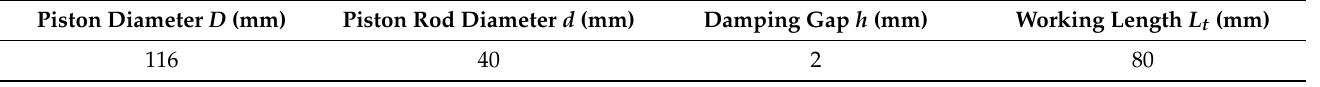
Table 3. Dimensions of the MR damper.